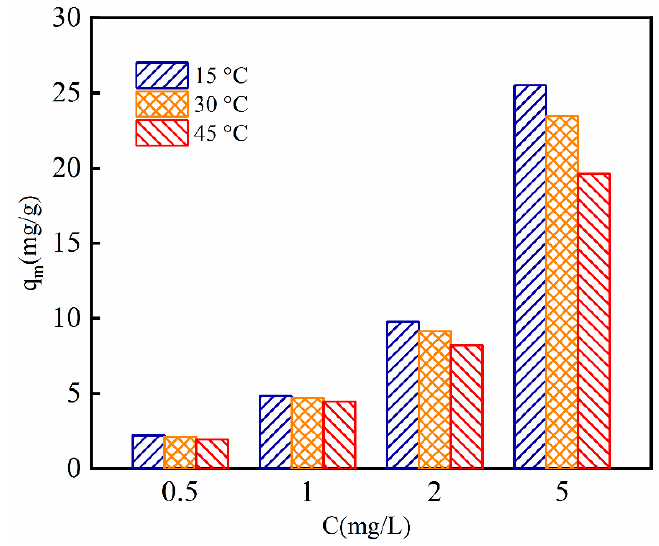
Figure 4. Effect of temperature on TCS adsorption by carbon black.